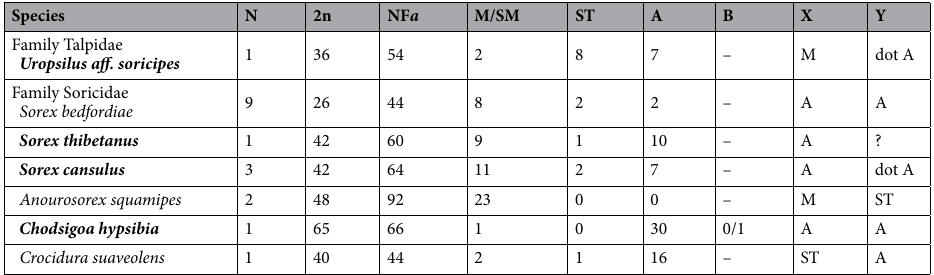
Table 1. A summary of karyotypes of the analysed species collected in China. Only a female individual of Sorex thibetanus was karyotyped, and therefore sex chromosomes could not be identified. N, sample size; 2n, diploid chromosomal number; NF a , fundamental number of autosome arms; M/SM, metacentric or submetacentric; ST, subtelocentric; A, acrocentric; B, B chromosome; X and Y, sex chromosome. Species karyotyped for the first time are highlighted in